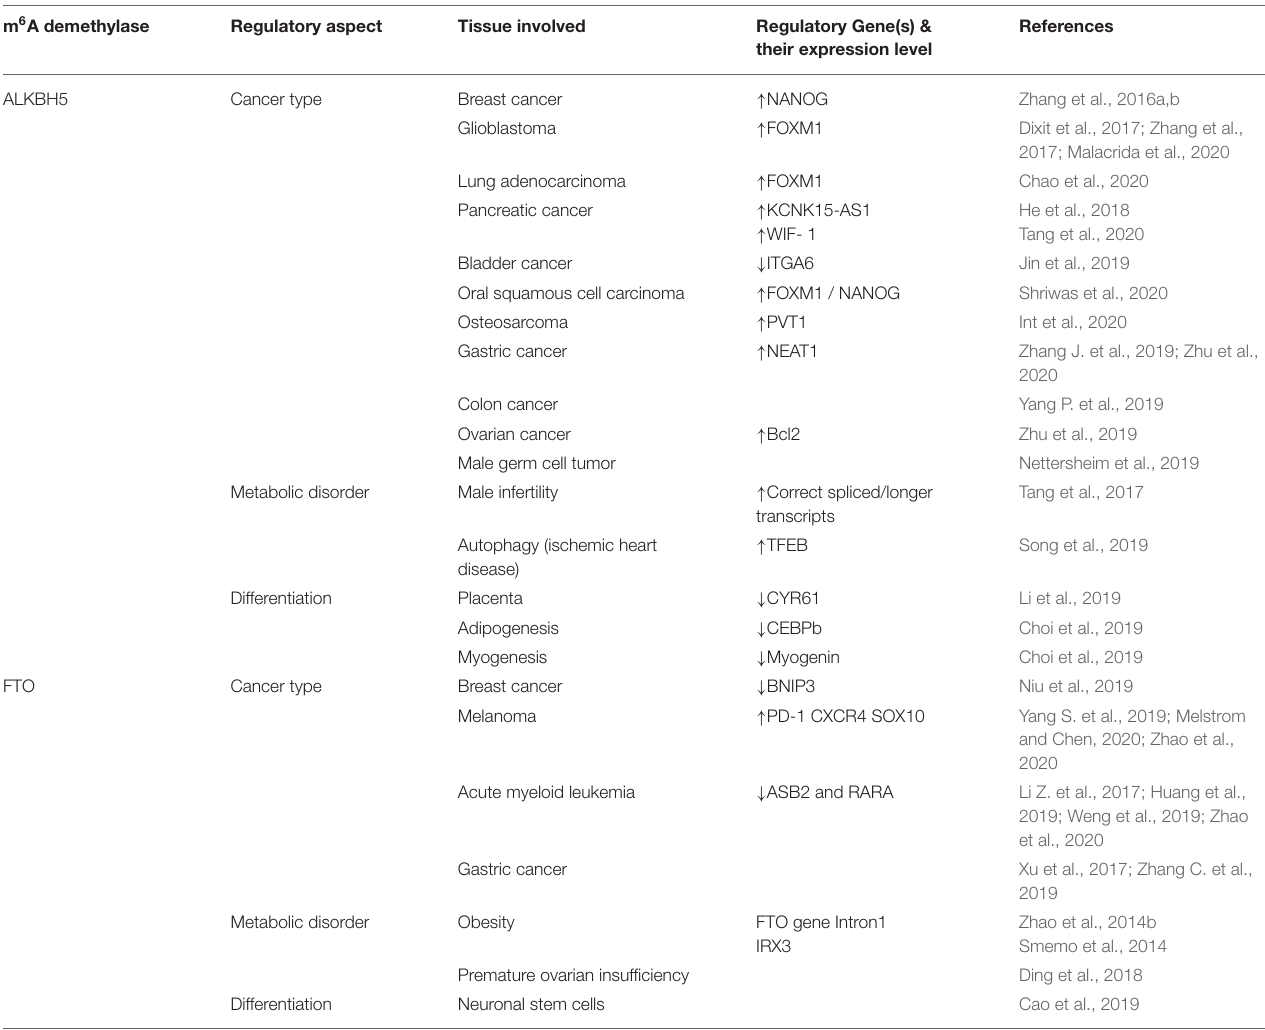
TABLE 1 | Regulatory aspects of m 6 A